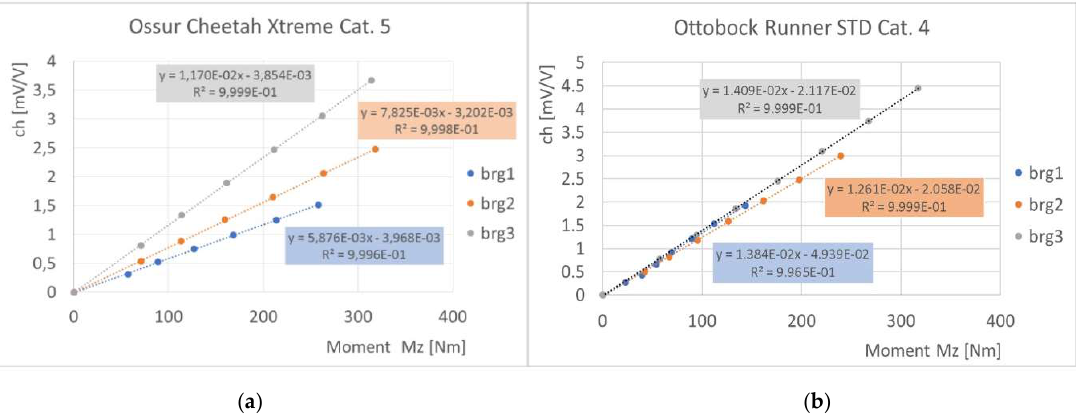
Figure 10. Results of bridge calibration of the instrumented RPF: bridge output (in mV/V) of the three bending bridge channels (brg1, brg2, and brg3) subjected to increasing bending moments; ( a ) Össur,